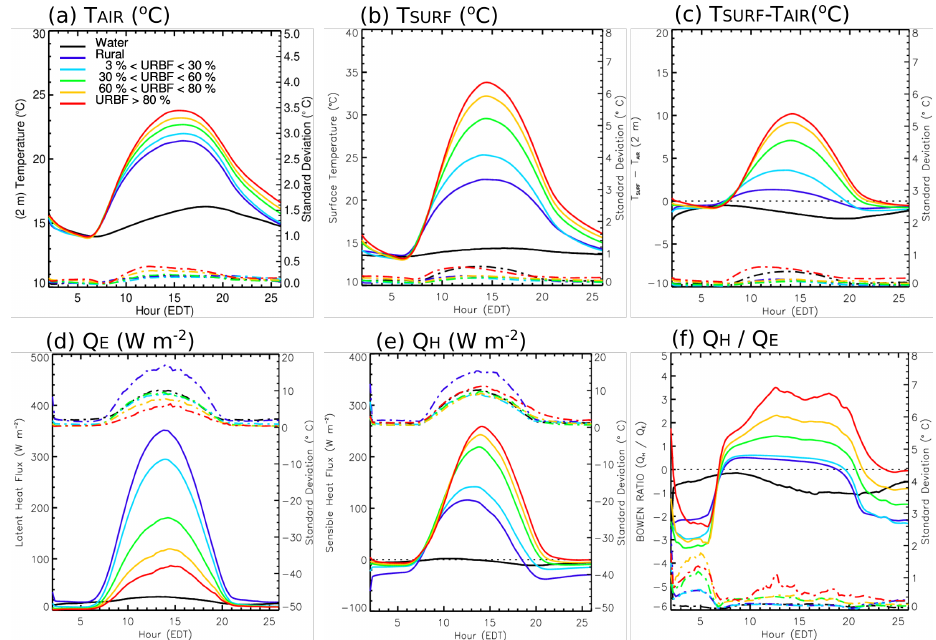
Figure 8. TOR-GEM250 daily time series by LULC categories averaged for the period 13-May–31-Aug. and for the same domain as Figure 7. ( a ) Air temperature at 1.5 m, ( b ) Skin surface temperature, ( c ) surface-air temperature difference, ( d ) latent and ( e ) sensible heat fluxes, and ( f ) Bowen ratio. Mean values for pixels with more than 50% of water (black), land pixels with less than 3% of URBan Fraction (URBF) (dark blue), land pixels with 3% < URBF < 30% (light blue), 30% < URBF < 60% (green), 60% < URBF < 80% (yellow),and above 80% (red). Refer to Figure 3b for the correspondence between colors and the location of pixels. Dash-dotted lines with the same colors are for the standard deviation among